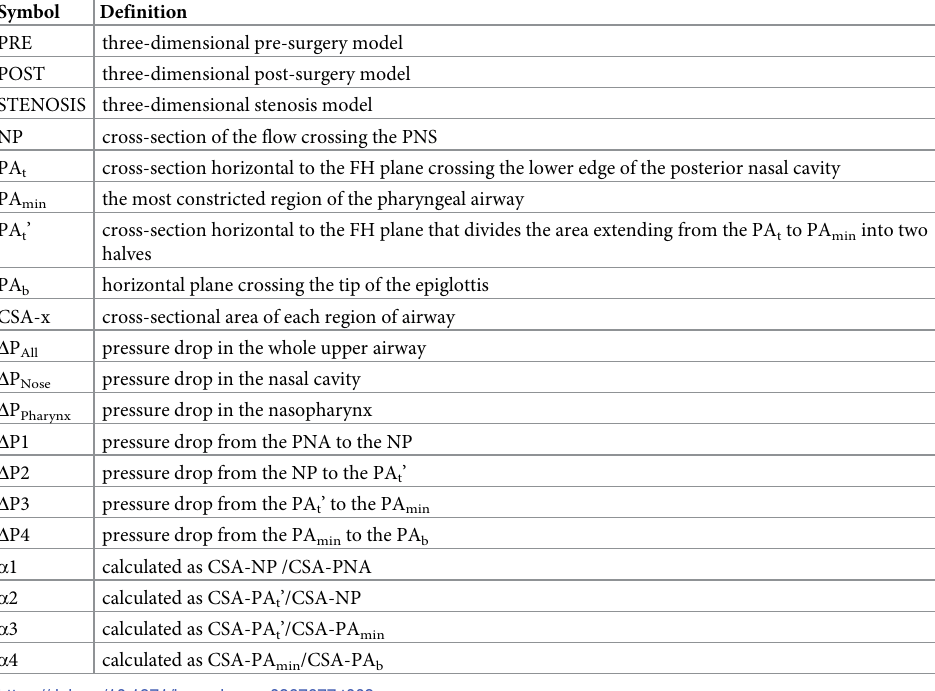
Table 2. Definitions of measurements